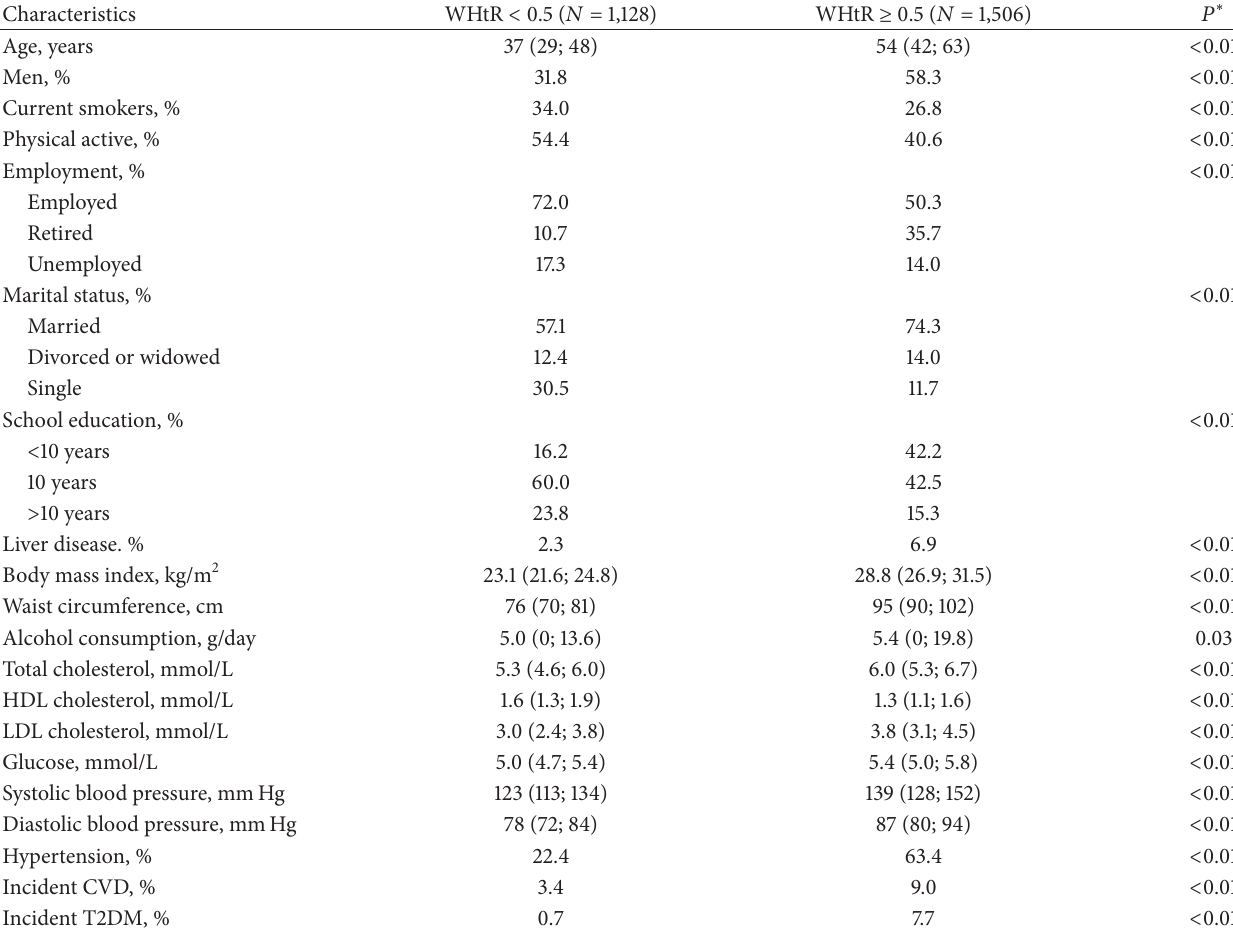
Table 1: Baseline characteristics of the study